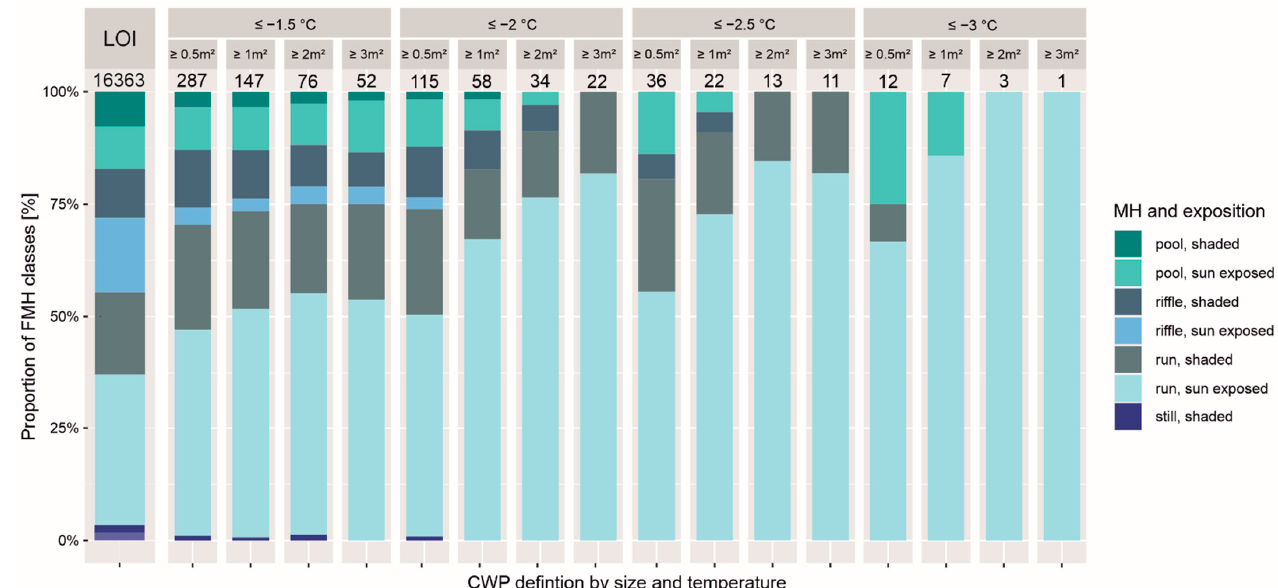
Figure 5. Total numbers and proportions of MHs present in the total area ( left panel) vs. the cold-water patch (CWP) area ( right panels) of the five analyzed LOIs. The right panels represent the different definitions of CWPs based on patch size and relative thermal thresholds. Note: numbers on the top of each panel reflect MH ( left panel) and CWP ( right panels) numbers.